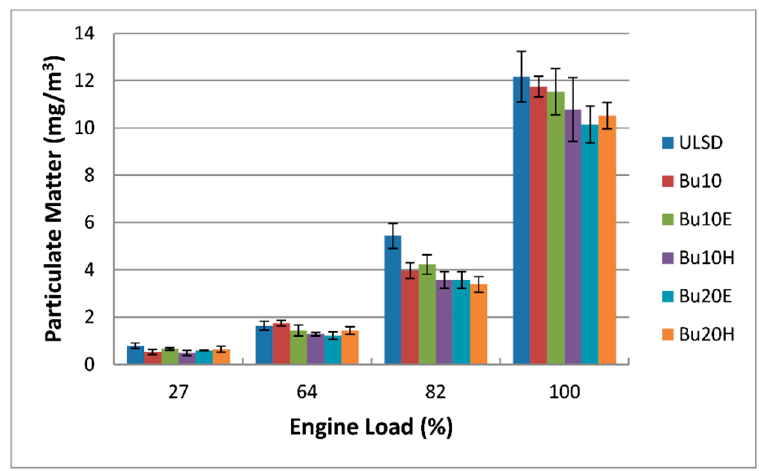
Figure 12. Particulate matter emissions of the six fuels with the same DCN.